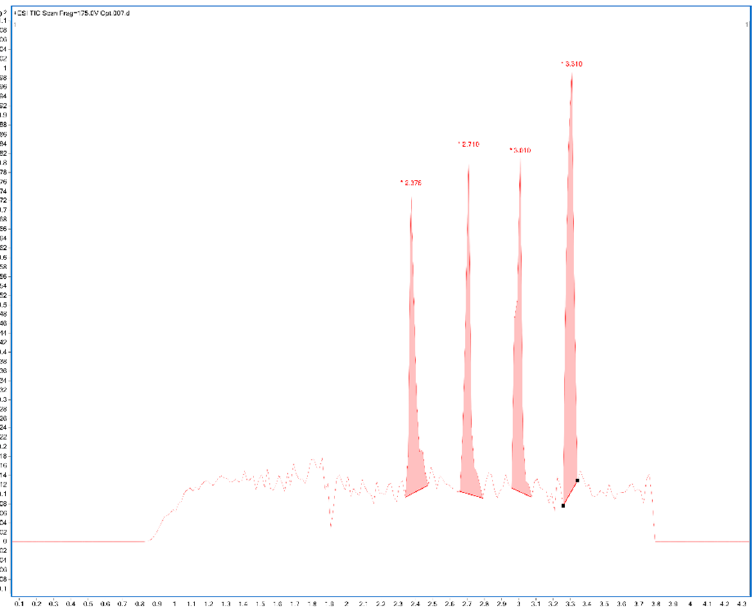
Figure 1. Example of the chronogram obtained after measuring in four parallels (TIC—total ion current chromatogram) of sample 2% CMC after manual integration in positive ionization mode (CMC: carboxymethylcellulose).